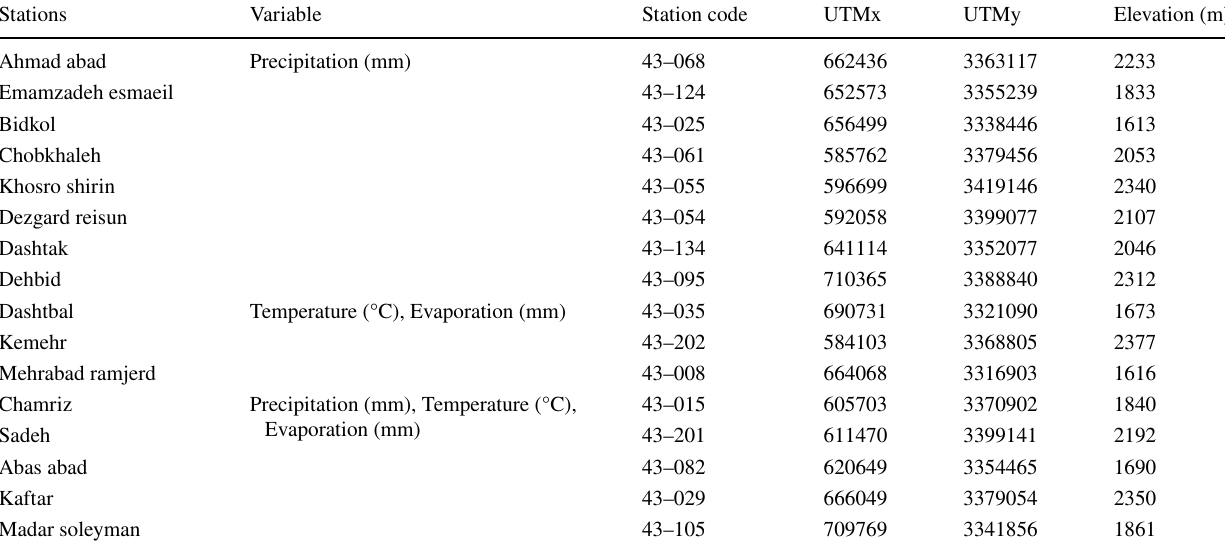
Table 1 Specifications of the stations used Stations